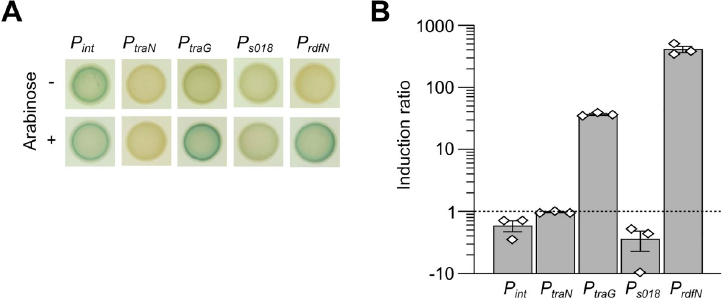
Fig 4. β -galactosidase activities of the promoters P int , P traN , P traG , P S018 and P rdfN of IME Vch USA3 transcriptionally fused to lacZ . (A) Colonies were grown on LB agar with or without arabinose to induce acaDC expression from pBAD- acaDC . (B) Induction levels of the same promoters in response to AcaCD. β -galactosidase assays were carried out using the strains of panel A. Ratios between the enzymatic activities in Miller units for the arabinose-induced versus non-induced strains containing pBAD- acaDC are shown. The bars represent the mean and standard error of the mean of three independent experiments.